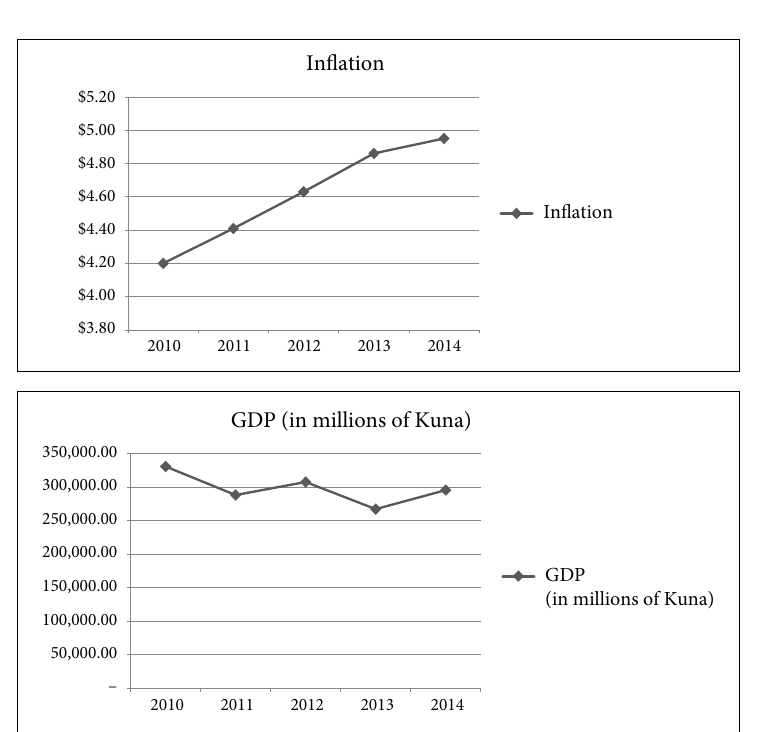
Fig. 3. The scenario of increasing inflation impact on GDp. Source: autors